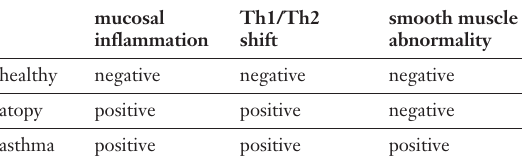
Table 1. The comparison of the clinical character- istics of asthma and atopic patients shows only in asthma pa- tients the three fol- lowing parameters: sub-mucosal inflam- mation, Th1-Th2 shift, and an abnor- mality of the smooth muscle cells